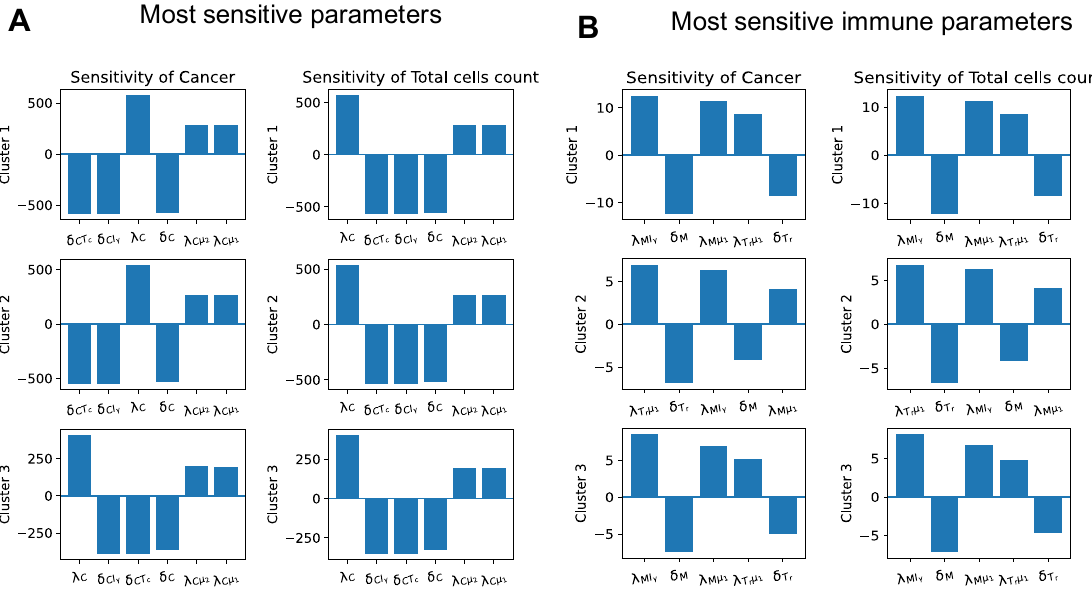
Figure 5. Sensitivity analysis. ( A ) The sensitivity level of the most sensitive parameters for cancer and total cell population at the steady state. ( B ) The most sensitive parameters associated with immune cells. The most sensitive parameters for each cluster are shown in each row of